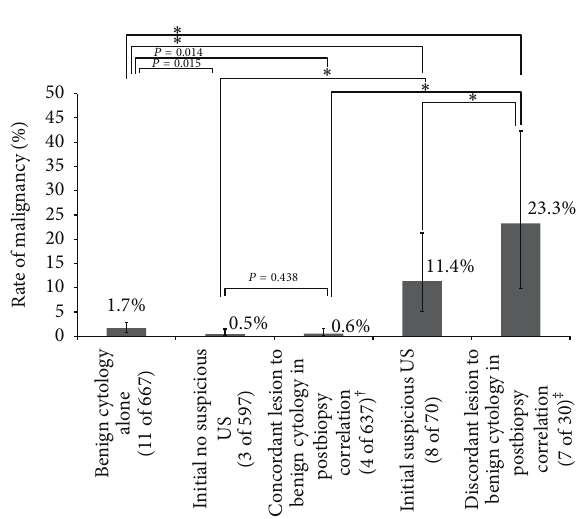
Figure 4: Comparison of malignancy rates in thyroid nodules with benign cytology according to initial US features or imaging- cytology concordance. Error bars for 95% confidence intervals. ∗ 𝑃 value < 0.001. † Concordant lesions include some nodules which had suspicious US features on initial US but were acceptable for benign cytology in postbiopsy image review as well as nodules without suspicious US features on initial US. ‡ Discordant lesions include nodules which were initially suspected for malignancy on US and were still regarded as suspicious even after obtaining benign